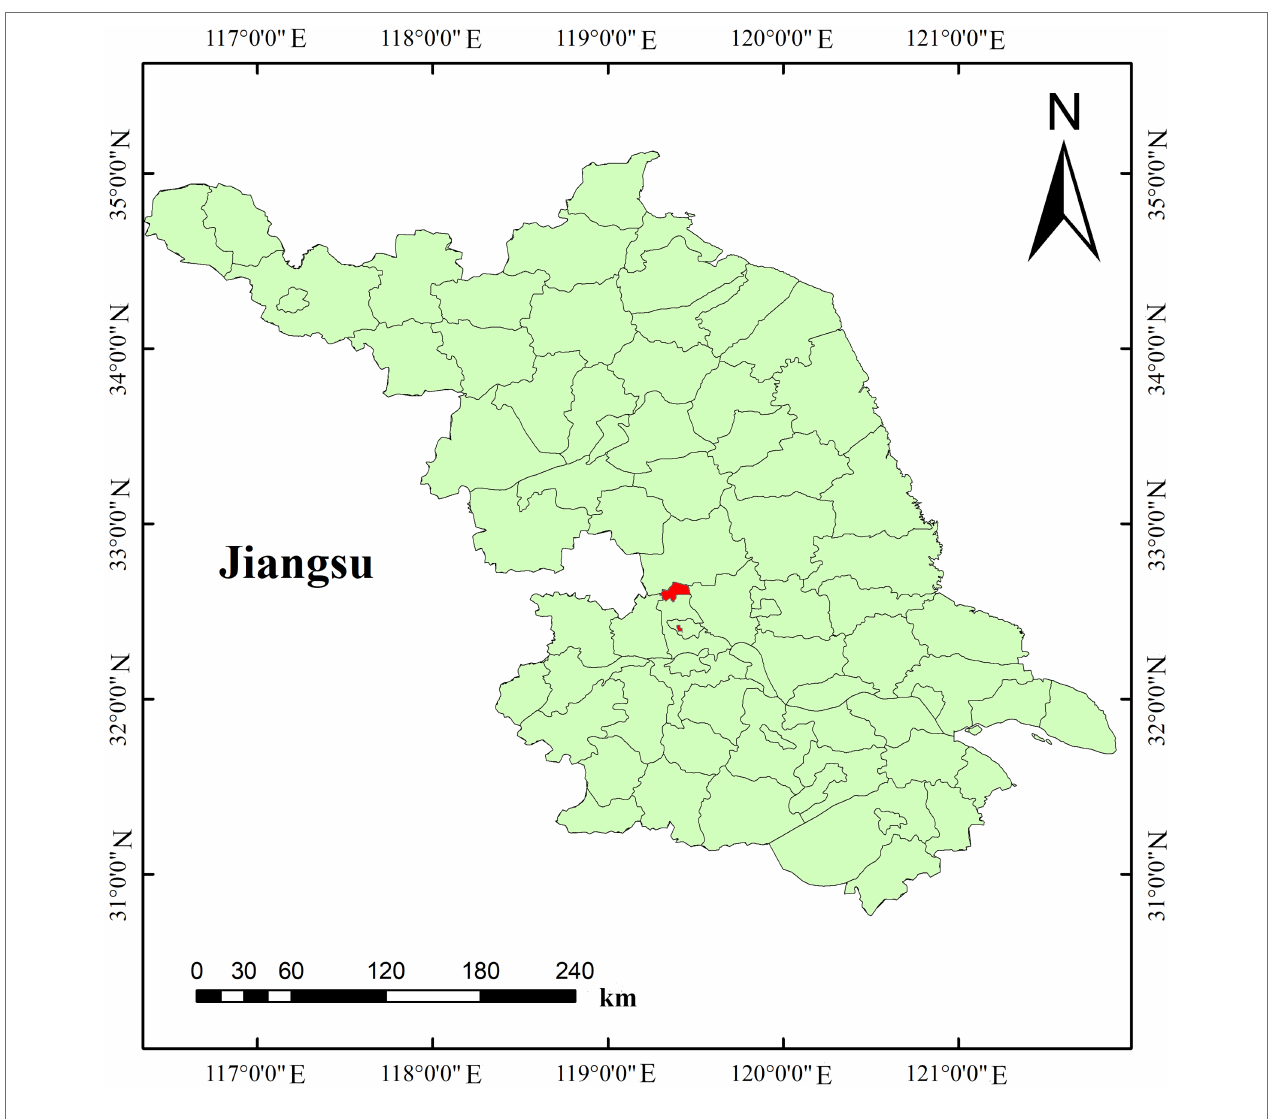
FIGURE 2 | Experimental area